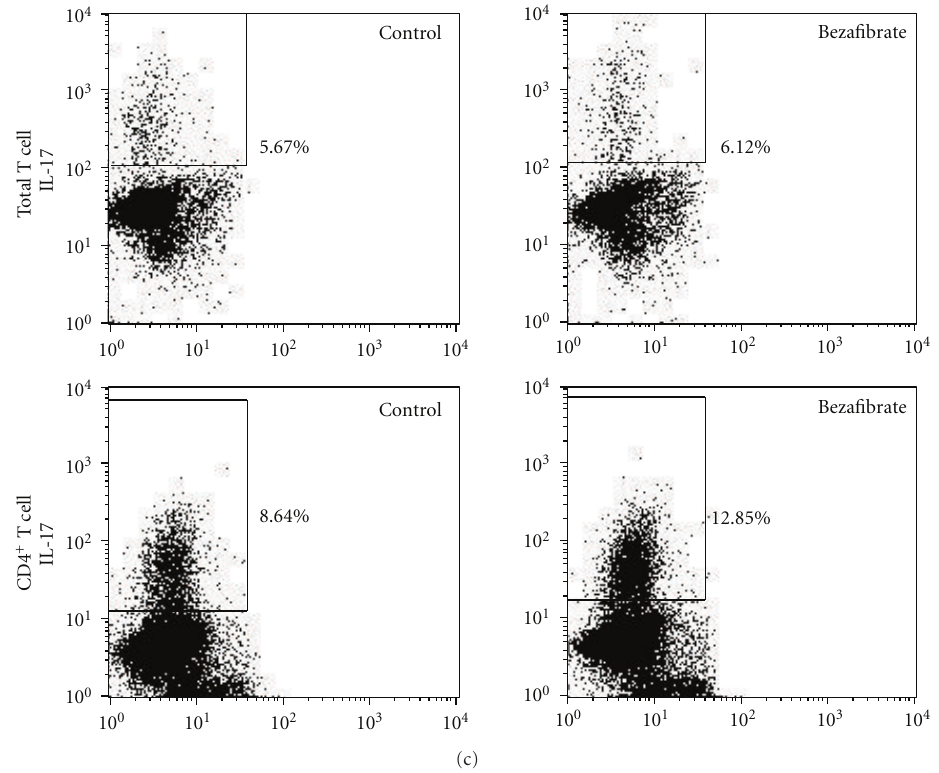
Figure 3: WY14643, GW7647, and bezafibrate did not inhibit the di ff erentiation of Th17 cells. Total T cells and CD4 + T cells were isolated from mouse spleens and induced di ff erentiation to Th17 cells with 10ng/mL TGF- β , 40 ng/mL IL-6, 5 μ g/mL IFN- γ neutralizing antibody, 5 μ g/mL IL-4 neutralizing antibody, and 20 μ M WY14643 (a), 1 μ M GW7647 (b), 50 μ M bezafibrate (c) or solute control. 4 days later, the percentage of IL-17 + T cells was analyzed with flow cytometry. Numbers adjacent to the outlined areas indicate the percentage of IL-17 + cells. Data shown here represent one of three independent